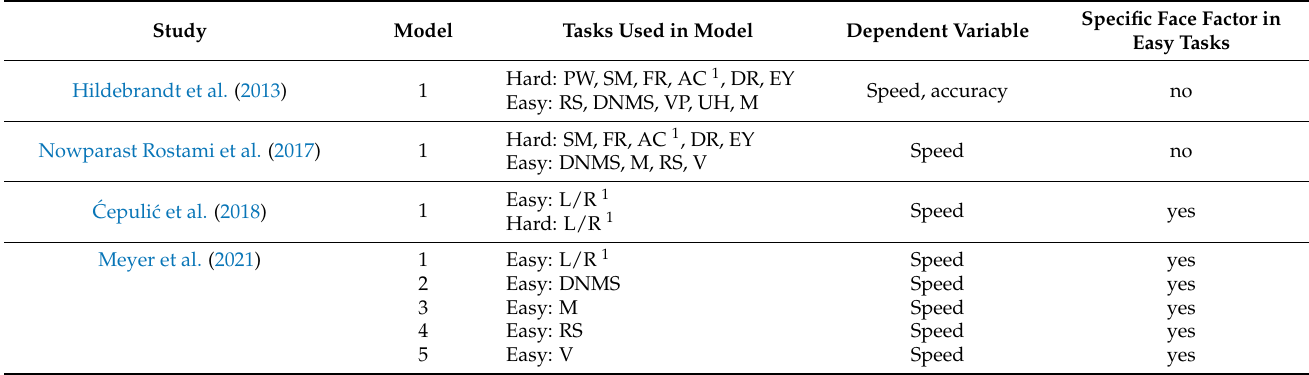
Table 2. Summary of studies investigating face specificity in